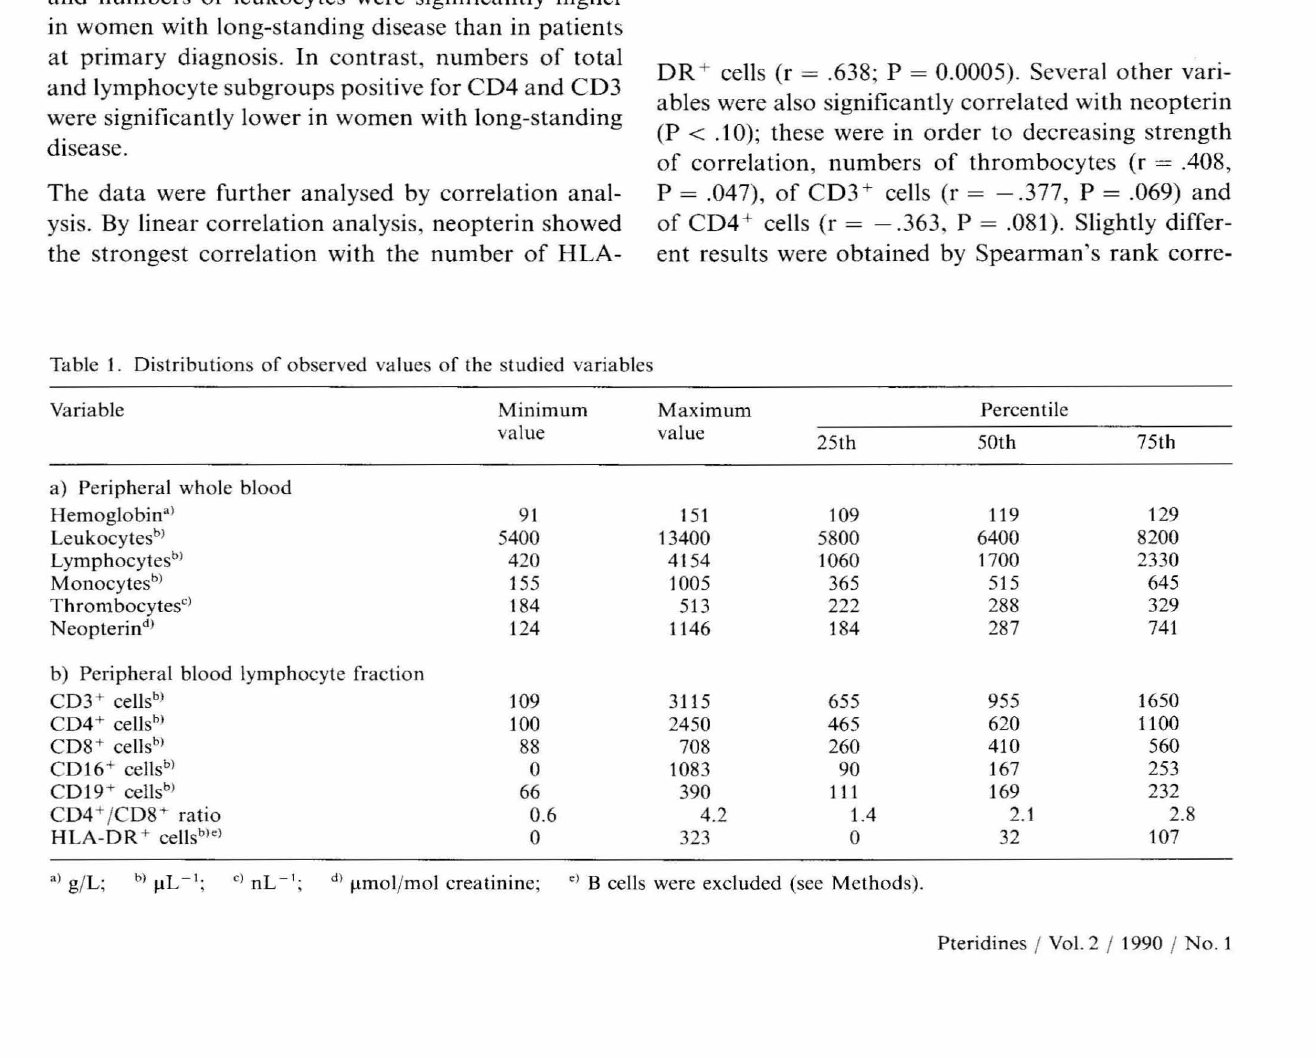
DR + cells (r = .638; P = 0.0005). Several other vari ables were also significantly correlated with neopterin (P < .10); these were in order to decreasing